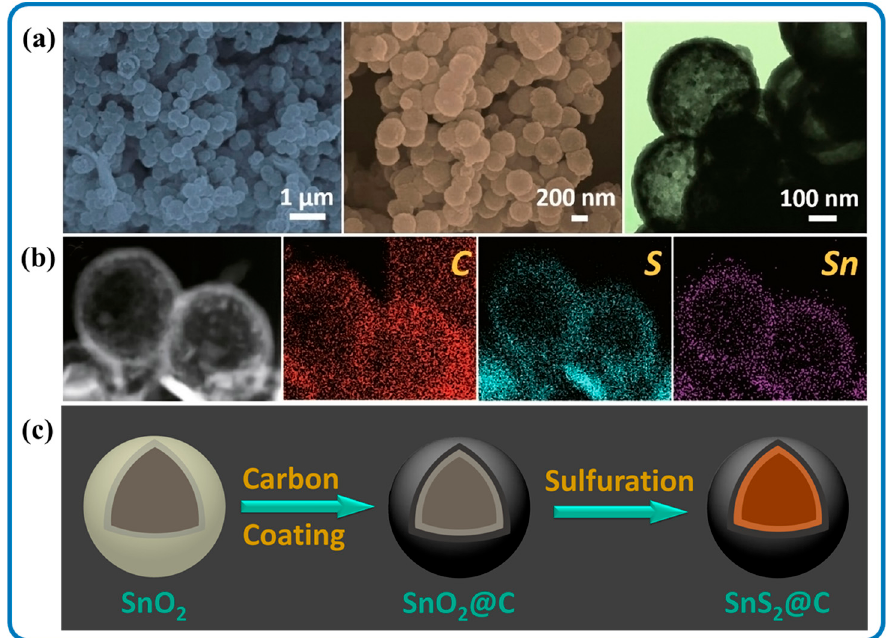
Figure 13. ( a ) TEM images of composite SnS 2 /C, ( b ) elemental mapping images of C, S, and Sn, ( c ) Schematic illustration of SnS 2 /carbon nanocomposite fabricated from SnO 2 . Reproduced from [112]. Copyright 2019, Springer, Open Access.